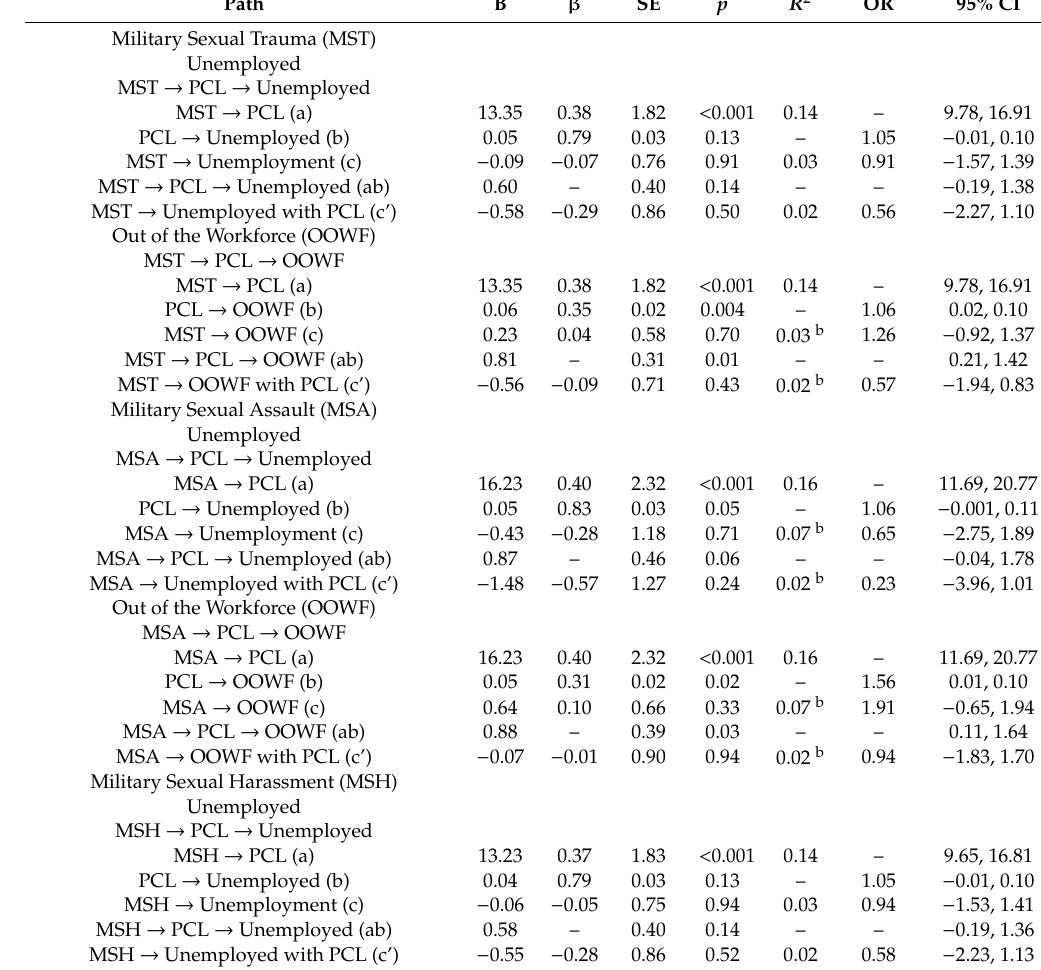
Table 4. Associations between trauma types and employment status, with PTSD symptoms as a